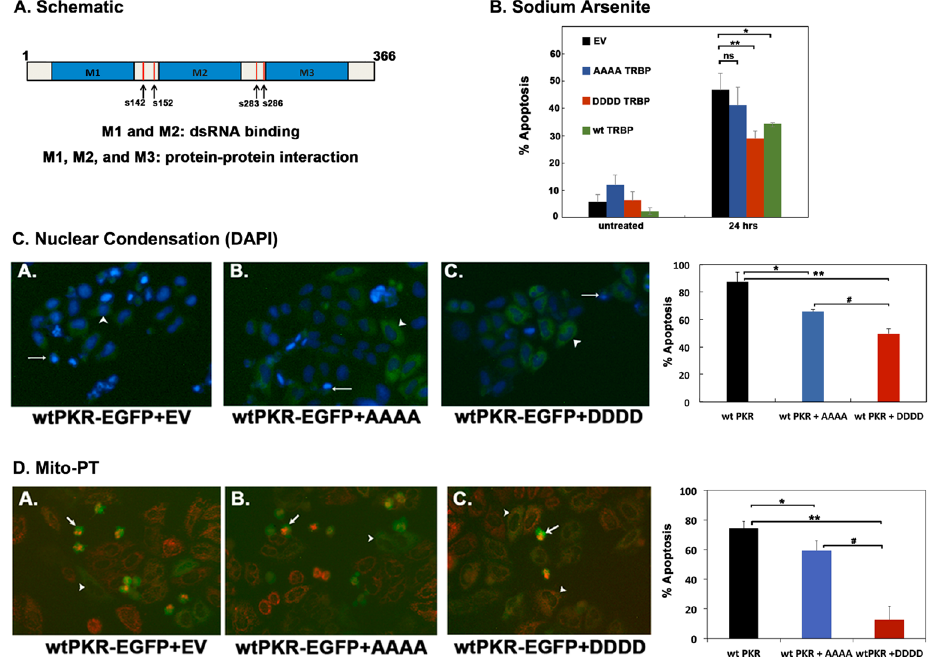
Figure 3. TRBP phosphorylation inhibits PKR-mediated apoptosis during cell stress. ( A ) Schematic representation of TRBP phosphorylation sites. Blue boxes represent the three double-stranded RNA binding motifs (dsRBMs), M1, M2, and M3. Red vertical lines represent previously identified ERK 1/2 phosphorylation sites at S142, S152, S283, and S286. ( B ) Expression of phospho-mimic TRBP protects cells during oxidative stress. HeLa cells were transfected with 200 ng pEGFPC1 (EV) alone (black bars) or with 200 ng each of pEGFPC1 and Flag TRBP AAAA/pcDNA 3.1 − (blue bars), 200 ng each of pEGFPC1 and Flag TRBP DDDD/pcDNA 3.1 − (red bars) or 200 ng each of pEGFPC1 and Flag wt TRBP/pcDNA 3.1 − (green bars). 24 hours after transfection, the cells were treated with 25 μ M sodium arsenite, fixed and stained with DAPI nuclear stain. At least 300 EGFP- positive cells were scored as apoptotic or live based on nuclear condensation indicated by intense DAPI nuclear staining and cell morphology. The percentage of cells undergoing apoptosis (% apoptosis) was calculated using the formula: (EGFP- expressing cells with intense DAPI nuclear staining/Total EGFP-expressing cells) x 100. Bars represent averages ± S.D. from three independent experiments. One-way ANOVA followed by post-hoc Tukey test was performed, ns: not significant, asterisk * p value of 0.043. asterisk ** p value of 0.007. ( C ) and ( D ) Phospho-mimic TRBP inhibits PKR mediated apoptosis more efficiently than phospho-defective TRBP ( C ) HeLa cells were plated on coverslips and transfected with 500 ng of wt PKR/pEGFPC1 and 20 ng of empty vector pCDNA3.1 − (wt PKR; black bar) or with 500 ng of wt PKR/pEGFPC1 + 20 ng of Flag TRBP AAAA/ pcDNA 3.1 − (blue bar) or 500 ng of wt PKR/pEGFPC1 + 20 ng of Flag TRBP DDDD/ pcDNA 3.1 − (red bar). 24 hours after transfection, the cells were fixed and mounted in Vectashield mounting media with DAPI nuclear stain. Representative fluorescent micrographs of HeLa cells transfected with wt PKR pEGFPC1 alone (Panel A), or in combination with Flag TRBP AAAA/pcDNA 3.1 − (Panel B) or Flag TRBP DDDD/pcDNA 3.1 − (Panel C) are shown. At least 500 EGFP-PKR expressing cells showing green fluorescence were scored as apoptotic (white arrows) or live (white arrowheads) based on nuclear condensation indicated by intense DAPI staining and cellular morphology. The cells showing intense DAPI staining and rounded morphology were scored as apoptotic. The percentage of cells undergoing apoptosis was determined as described in ( A ). Bars represent averages ± S.D. from three independent experiments. One-way ANOVA followed by post-hoc Tukey test was performed, asterisk * p value 0.0034, double asterisk ** p value 0.0002, # p value 0.0134. ( D ) Phospho-mimic TRBP expression abrogates mitochondrial depolarization during PKR-mediated apoptosis. HeLa cells were plated on coverslips and transfected with 500 ng of wt PKR/pEGFPC1 and 20 ng of empty vector pCDNA3.1 − (wt PKR; black bar) or with 500 ng of wt PKR/pEGFPC1 + 20 ng of Flag TRBP AAAA/pcDNA 3.1 − (blue bar) or 500 ng of wt PKR/pEGFPC1 + 20 ng of Flag TRBP DDDD/ pcDNA 3.1 − (red bar). 24 hours after transfection, changes in the mitochondrial potential of transfected cells were assessed using the MitoPT TMRM Assay kit and observed by fluorescence microscopy. Representative fluorescent micrographs of the cells transfected with wt-PKR pEGFPC1 alone (wt-PKR-EGFP + EV, Panel A), and AAAA TRBP (wt-PKR-EGFP + AAAA, Panel B) or DDDD TRBP (wt-PKR-EGFP + DDDD, Panel C) are represented. At least 500 PKR expressing cells (GFP positive, green fluorescent cells) were scored as live (white arrowheads) or dead (white arrows) based on decreased or absent red fluorescence. The PKR expressing, green fluorescent cells that showed diminished or no MitoPT staining (red fluorescence) were counted as apoptotic and the green fluorescent cells that showed good MitoPT staining (red fluorescence) were counted as live. The percentage of cells undergoing apoptosis (% apoptosis) was calculated using the formula: (EGFP- expressing cells with decreased or absent red fluorescence/Total EGFP-expressing cells) x 100. Bars represent averages ± S.D. from three independent experiments. One-way ANOVA followed by post-hoc Tukey test was performed, asterisk * p value 0.0108, double asterisk ** p value 0.0003, # p value